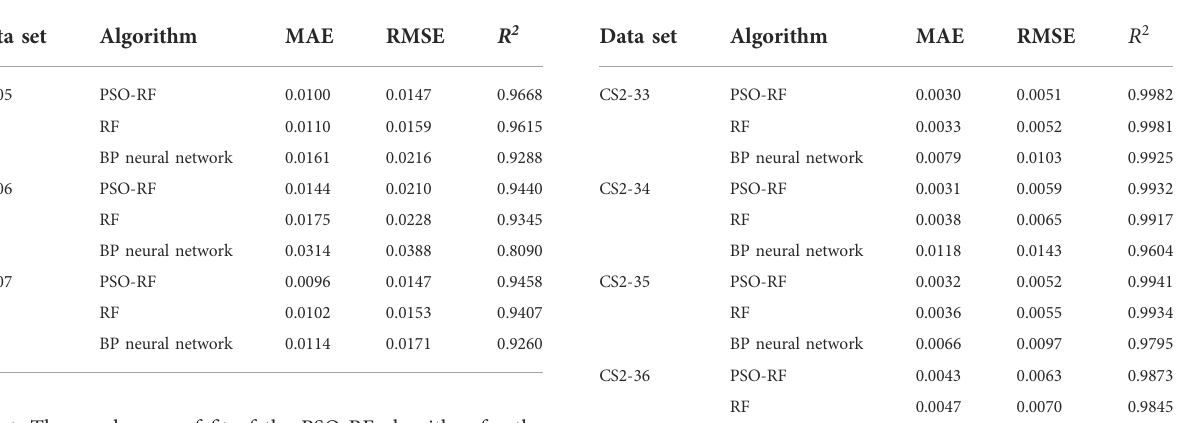
TABLE 6 The RUL prediction results of NASA data set. TABLE 7 The RUL prediction results of CALCE data